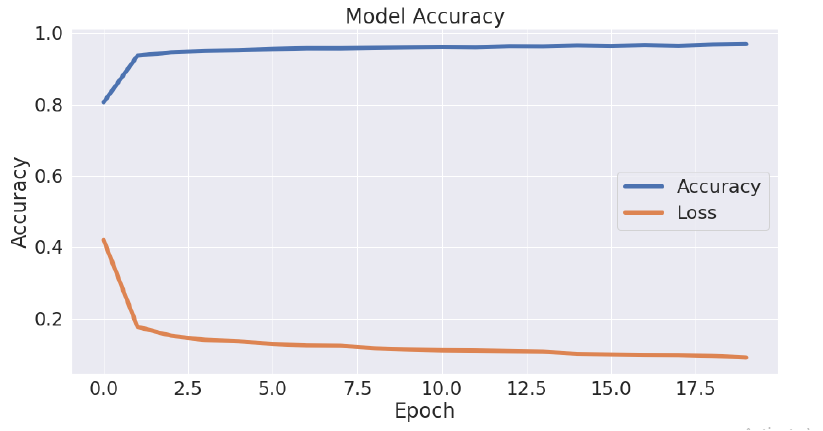
Figure 8. The accuracy vs. the loss during the validation phase.